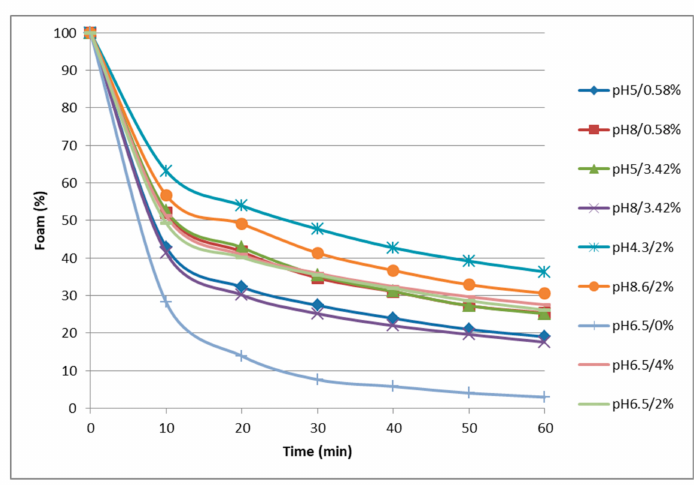
Figure 2. Vanishing kinetics of foam from porcine heart protein extracts (5 g L − 1 ), obtained with extraction bu ff ers at di ff erent pH and NaCl contents. Points refer to the relative percentage of the initial foam remaining at 10 min